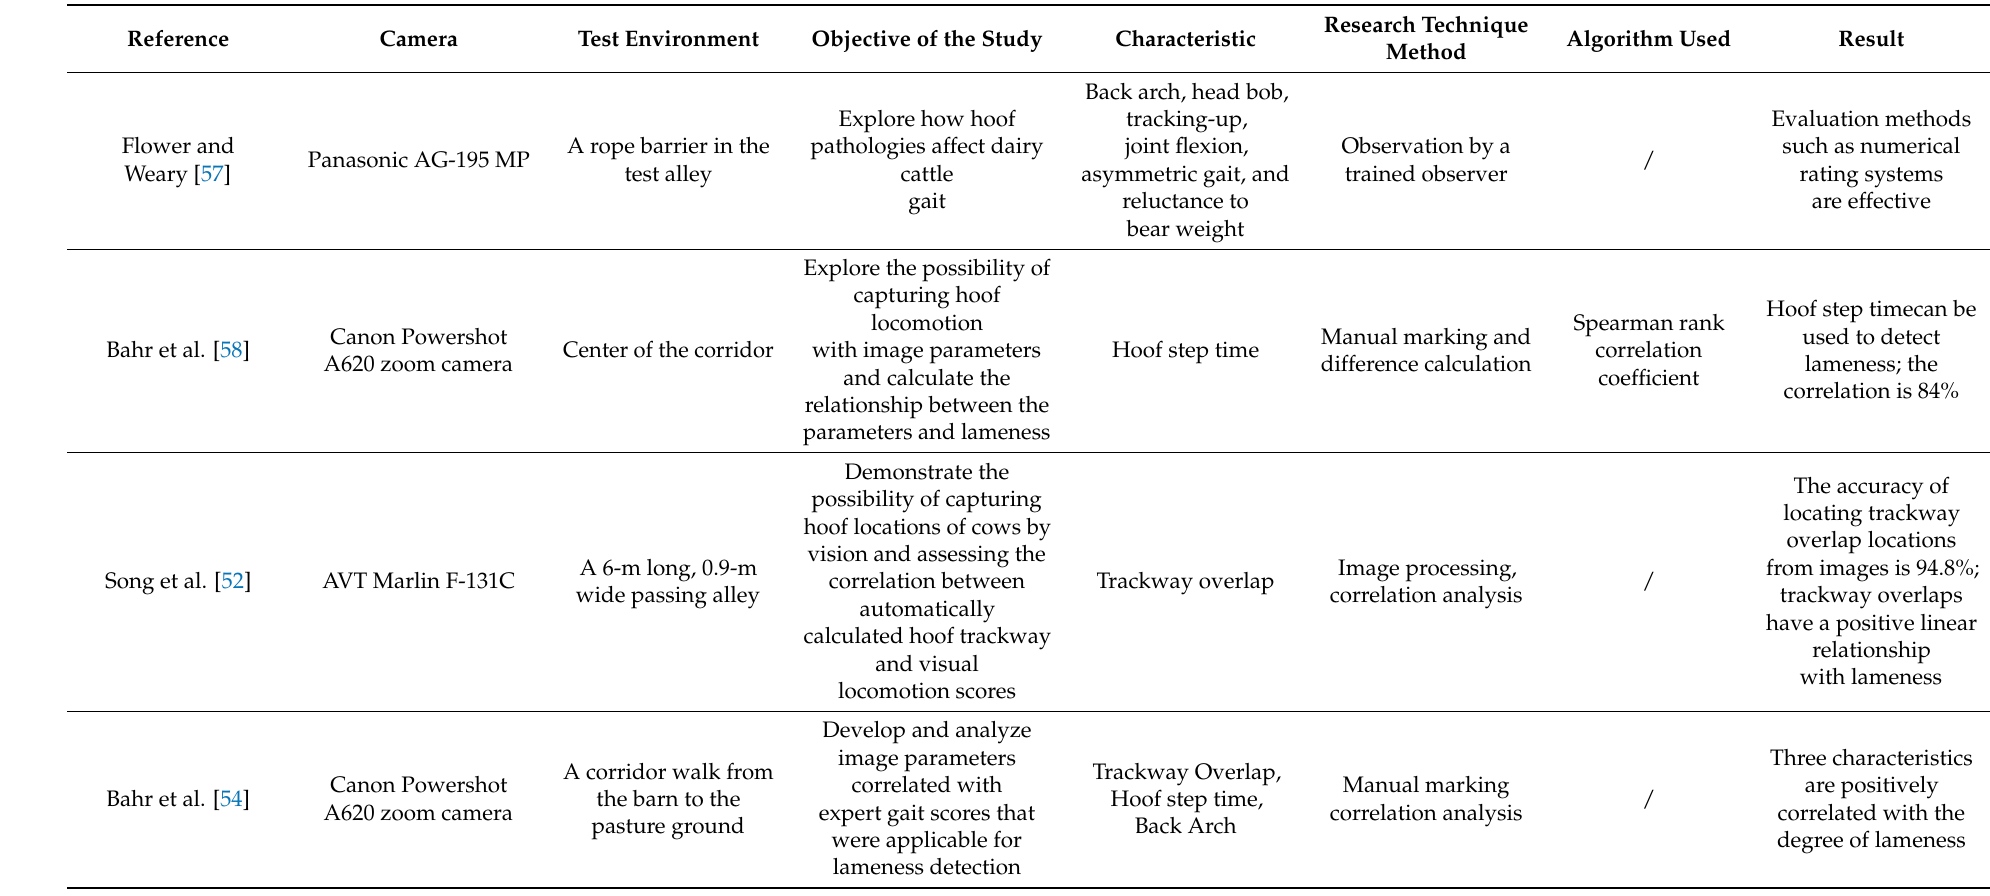
Table 1. Cow lameness detection methods based on 2D computer